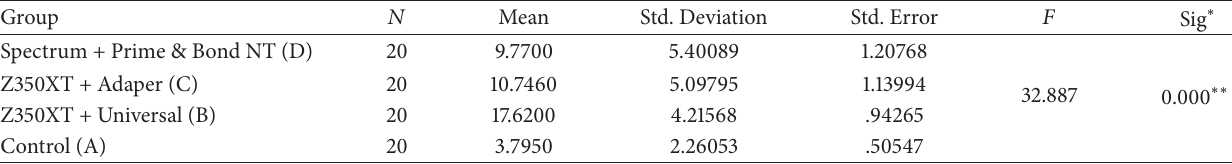
Table 1: Descriptive data of the shear bond strengths of the different groups.